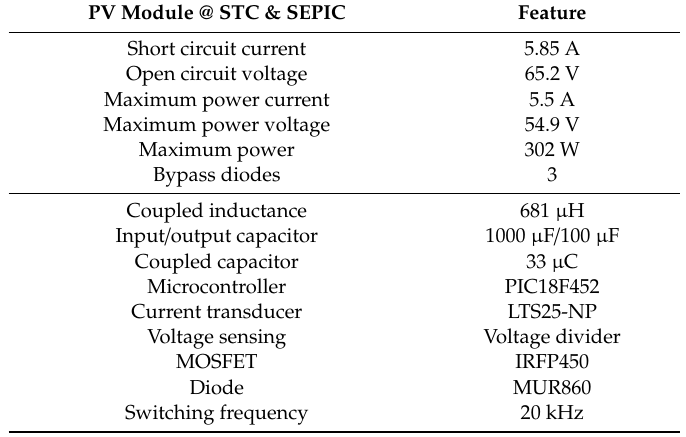
Table 1. Specifications of the PV module and single ended primary inductance converter (SEPIC).